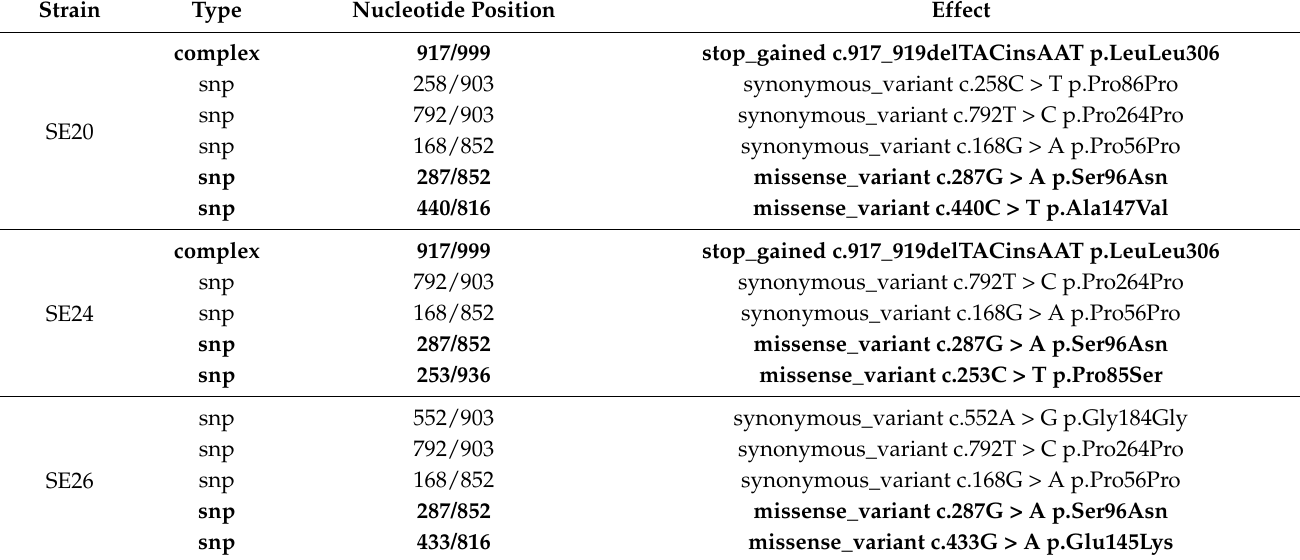
Table 3. P44/Msp2 family outer membrane protein variants between NL07 and Ca. N. mikurensis SE20, SE24, and SE20 assemblies. The effects of the SNPs are presented as synonymous (functionally silent) or nonsynonymous. Nonsynonymous variants, which lead to either a stop codon or a change in protein sequence, are in bold.